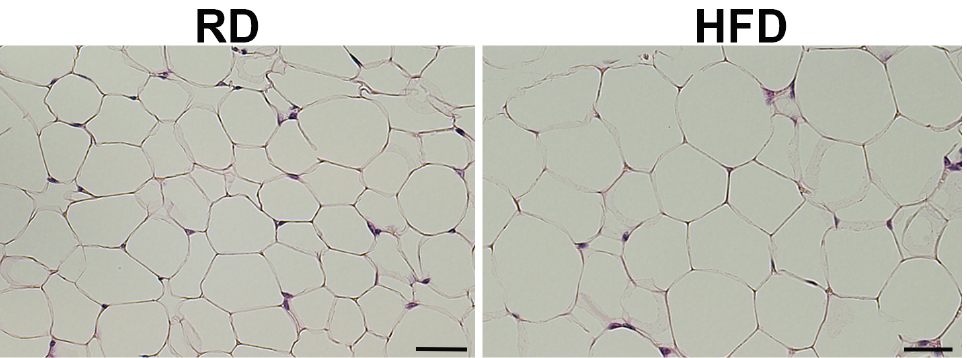
Figure 1. H&E-stained sections of an 8 weeks old healthy female C57BL/6J mouse mammary fat pad (n = 4/group). HFD-fed mice showed relatively bigger adipocytes in the mammary fat pad than RD mice (20× magnification, scale bar—50